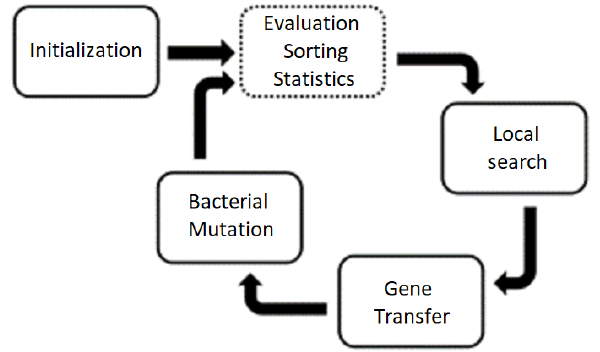
Figure 4. Bacterial memetic